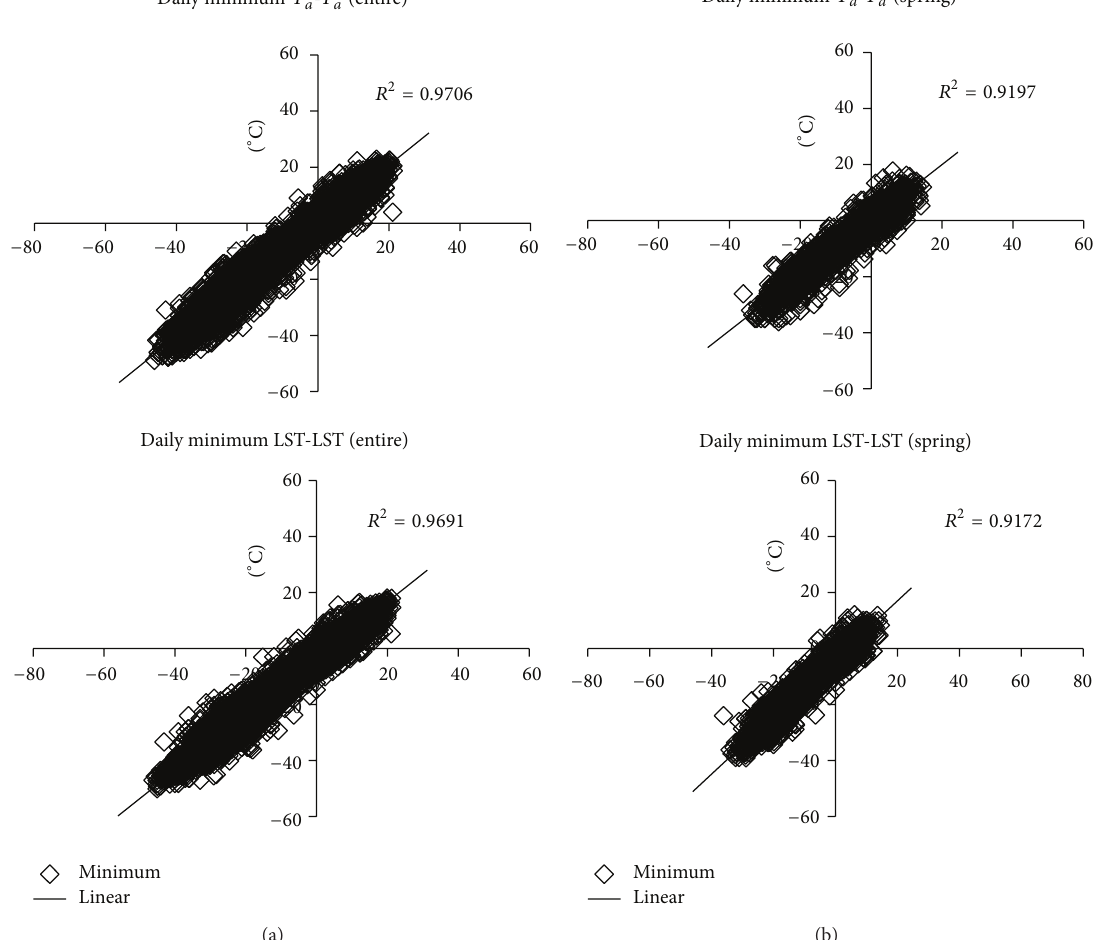
Figure 5: Scatter plot of daily minimum 𝑇 𝑎 creation results for 𝑇 𝑎 - 𝑇 𝑎 and LST-LST methods during the entire period (a) and spring (b), taking station pair 1-1 𝑁 as example.